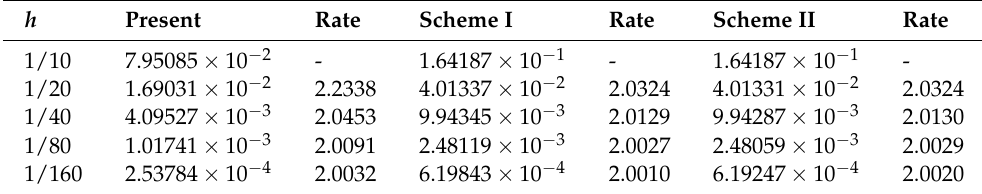
Table 1. Error comparison and spatial convergence orders in (cid:107) · (cid:107) ∞ -norm using ∆ t = 0.001 and T = 1. h